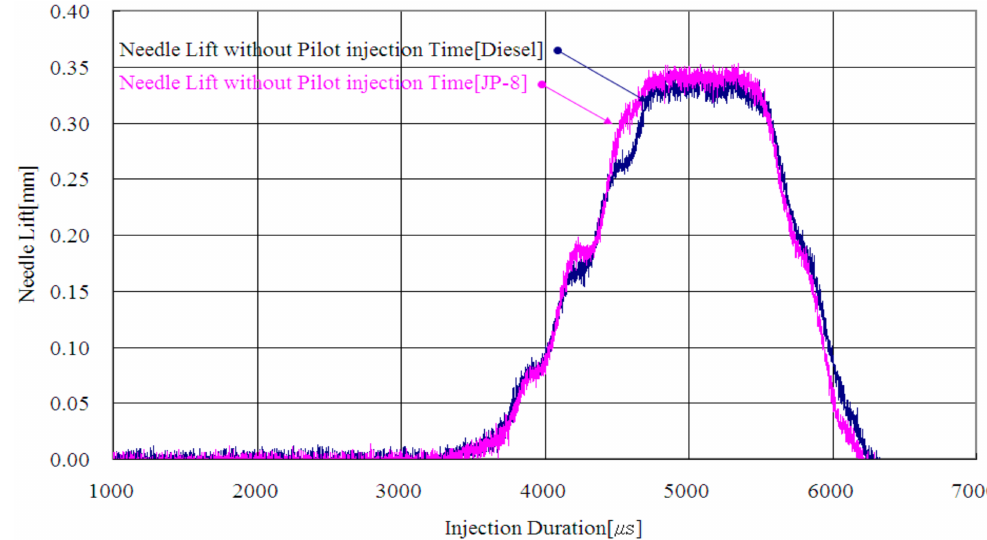
Figure 7. Needle lift characteristics during injections of diesel and JP-8 without pilot injection.